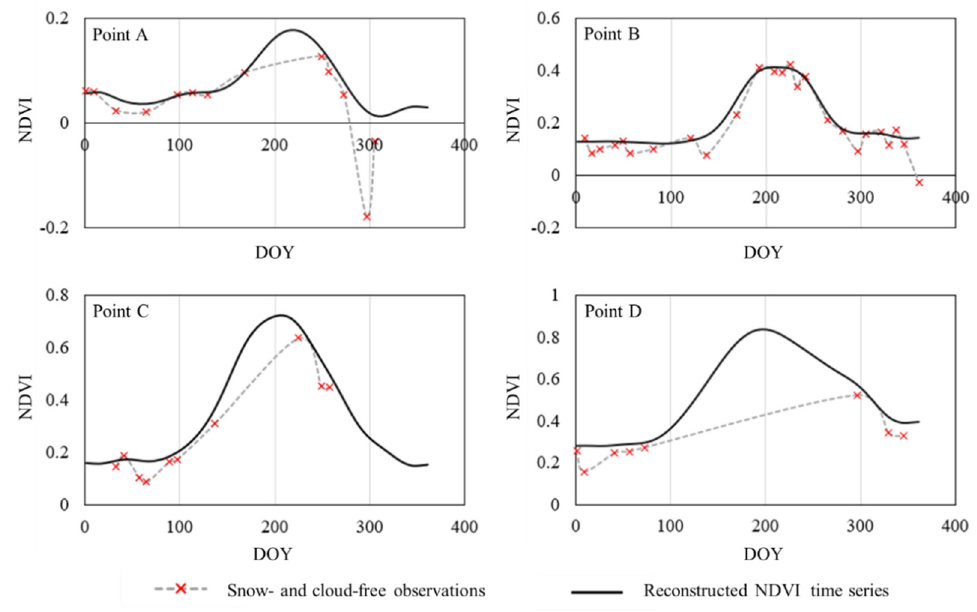
Figure 4. The original snow- and cloud-free Landsat observations (red cross) and the reconstructed Landsat NDVI time-series data at four locations (the locations are shown in Figure 3A).